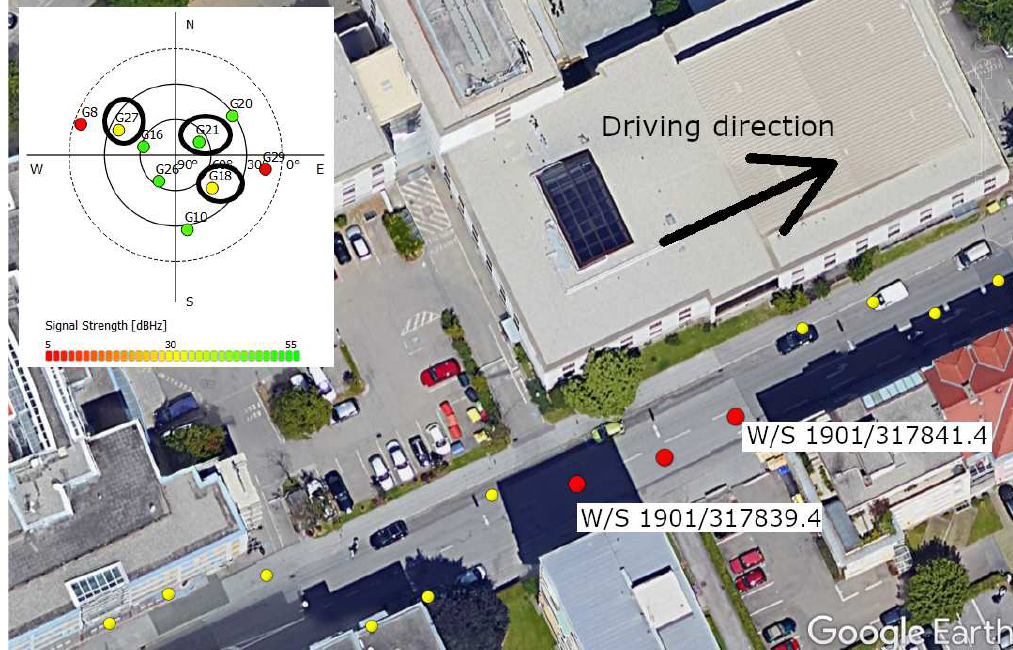
Figure 17. Environment for the urban scenario with three red measurement points. The driving direction was to the east, thus the red measurement points refer from left to the right column in Figure 14, Figures 15 and 16. The upper left plot shows the satellite constellation. The three analyzed satellites PRN 27, PRN 21 and PRN 18 are marked with a black circle. The measurement was taken in the Steyrergasse in Graz, Austria. The point at W/S 1901/317839.4 refers to LAT = 47.06430622 deg, LON = 15.45391867 deg. Map image c (cid:13) 2017 Google,